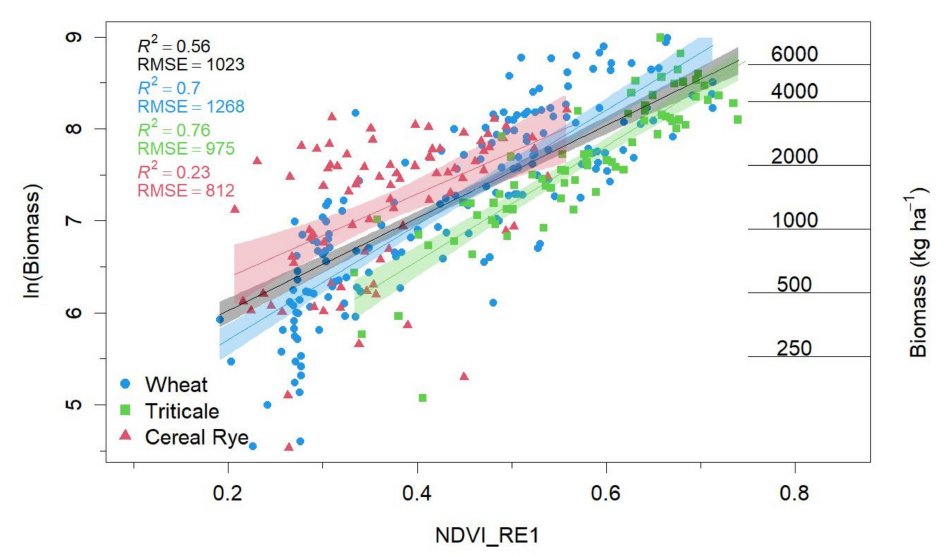
Figure 5. The natural log of cover crop biomass plotted against the normalized difference red-edge ( B8A − B5 ) index (NDVI_RE1), which is calculated as , where B5 is the 5th band of the Sentinel-2 ( B8A + B5 ) satellite (the first red edge band) and the narrow band near-infrared band (B8A). Only spring data are displayed (March–May). Model fits and errors are supplied in the upper left for the entire dataset (black) and by species. An untransformed biomass estimation is appended on the right of the figure for